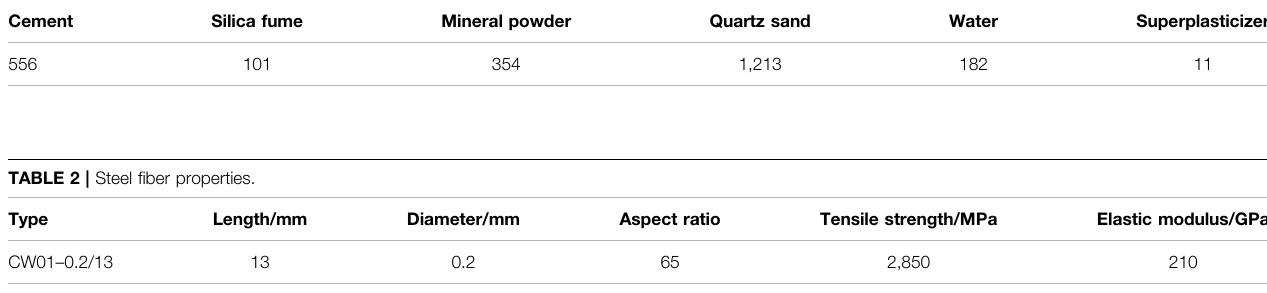
Frontiers in Materials |